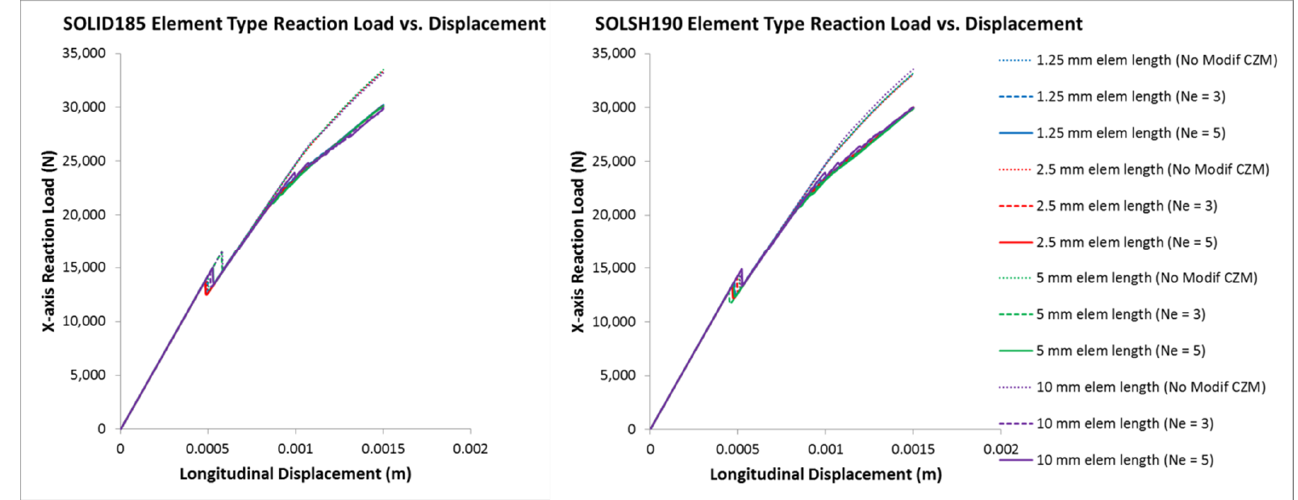
Figure 5. Load–displacement curves for different element types and element sizes.